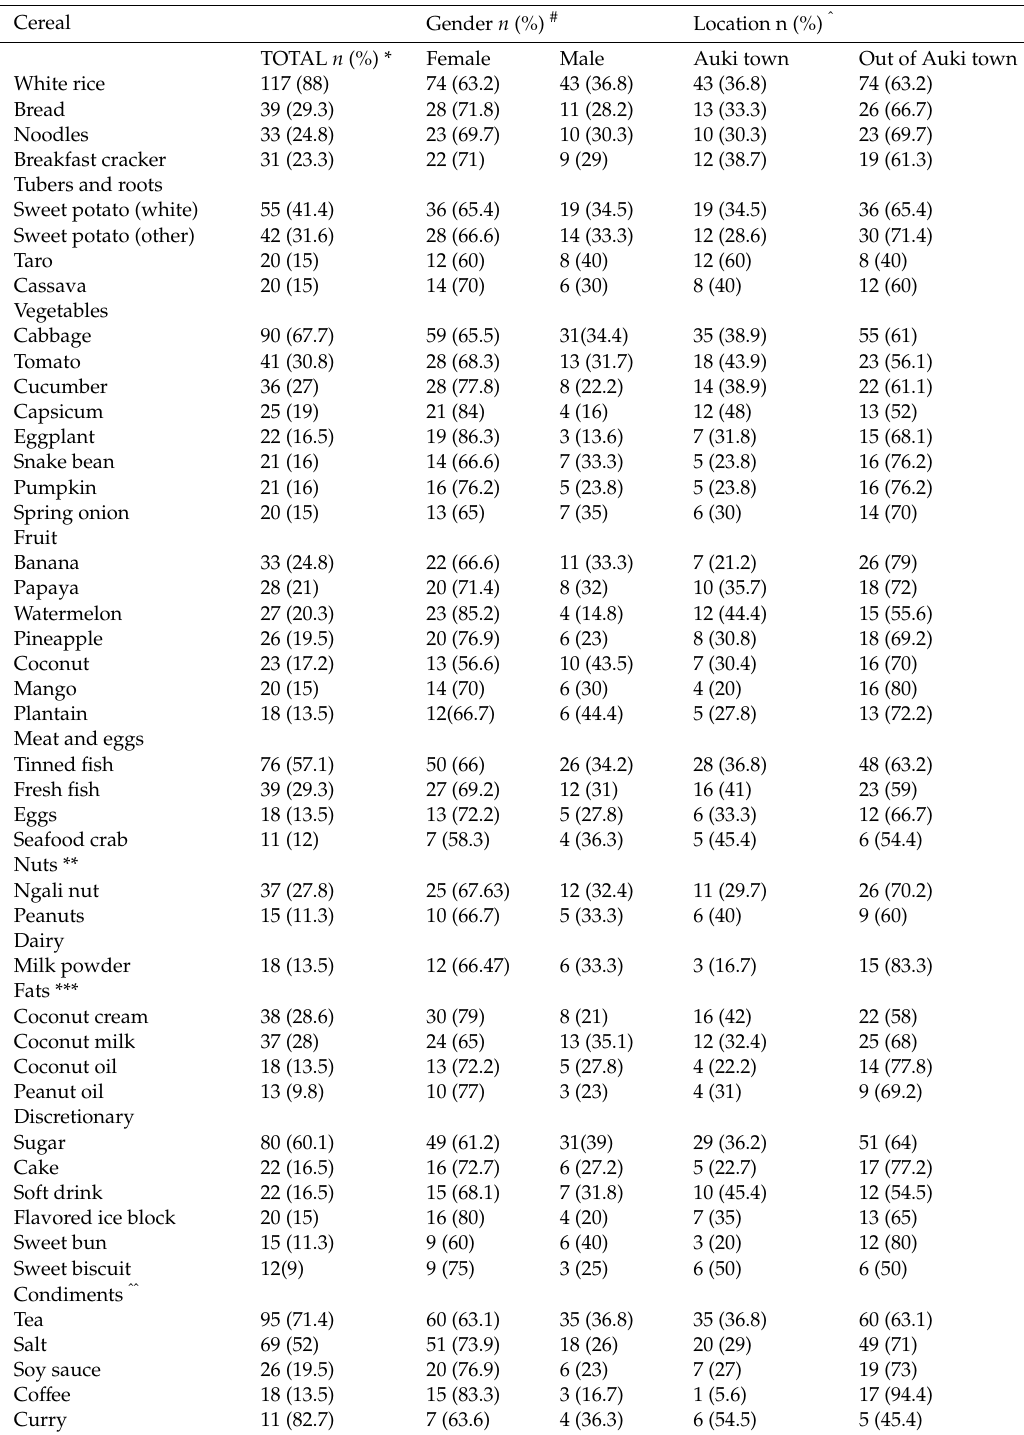
Table 5. Type of food items purchased based on sex and location (highest reported items from all food